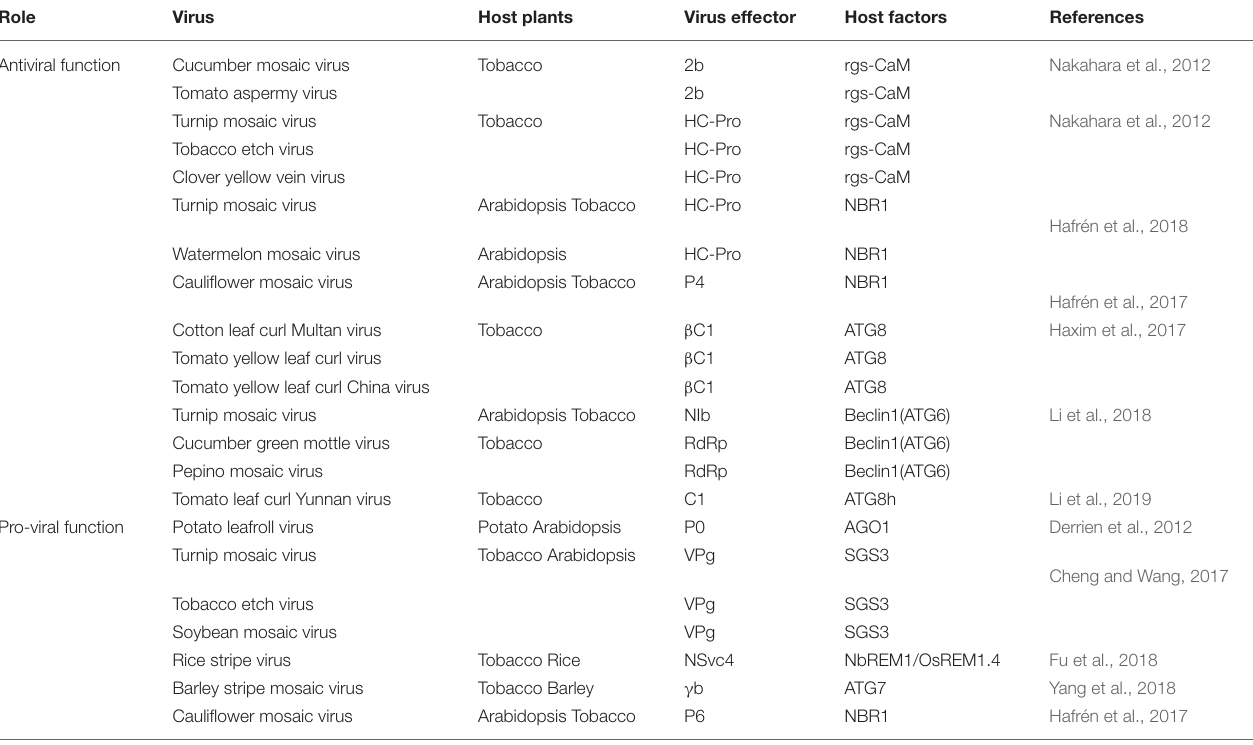
TABLE 1 | Summary of reported interactions between plant virus and host factors involved in